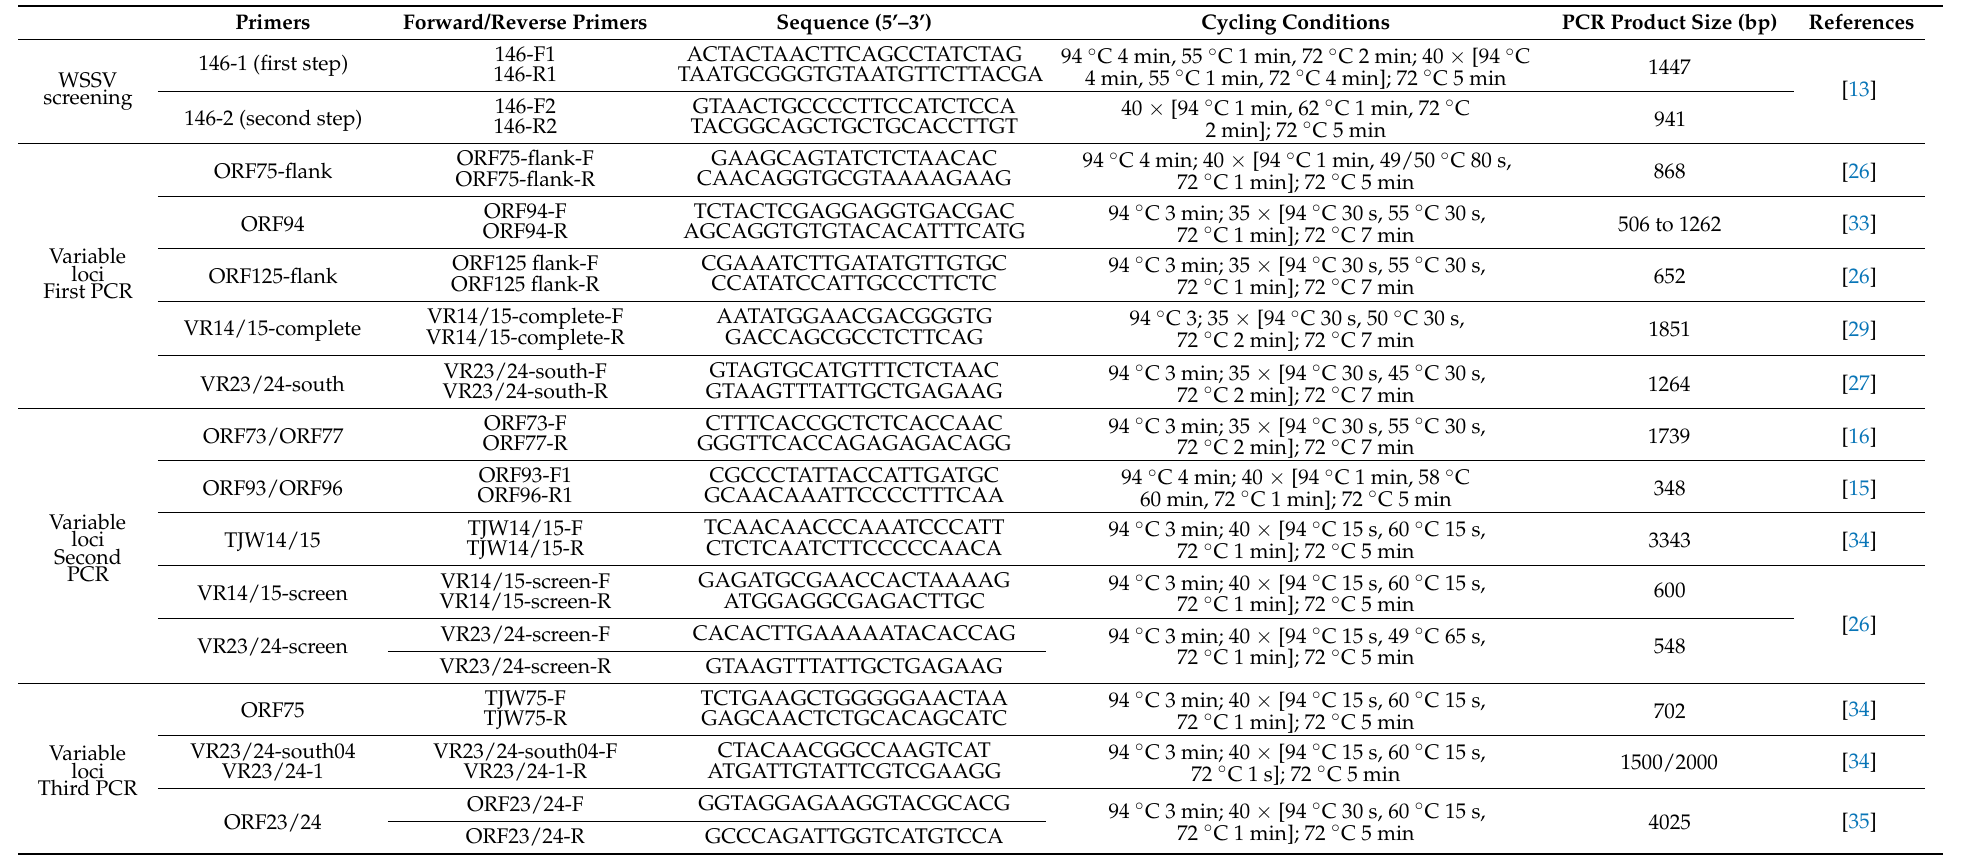
Table 1. Primers used and cycling conditions for WSSV screening and variable loci analysis. (ORF = Open reading frame, VR = Variable